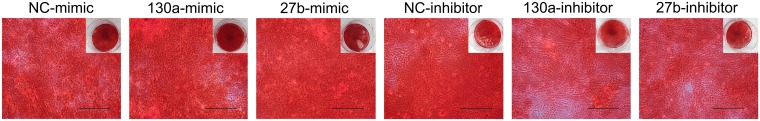
Staining of calcium deposition by alizarin red S in human MSCs after treatment with mimics and inhibitors of miR-130a and miR-27b along with their negative control under osteogenic differentiation medium for 21 days. Scale bars = 500 μm.